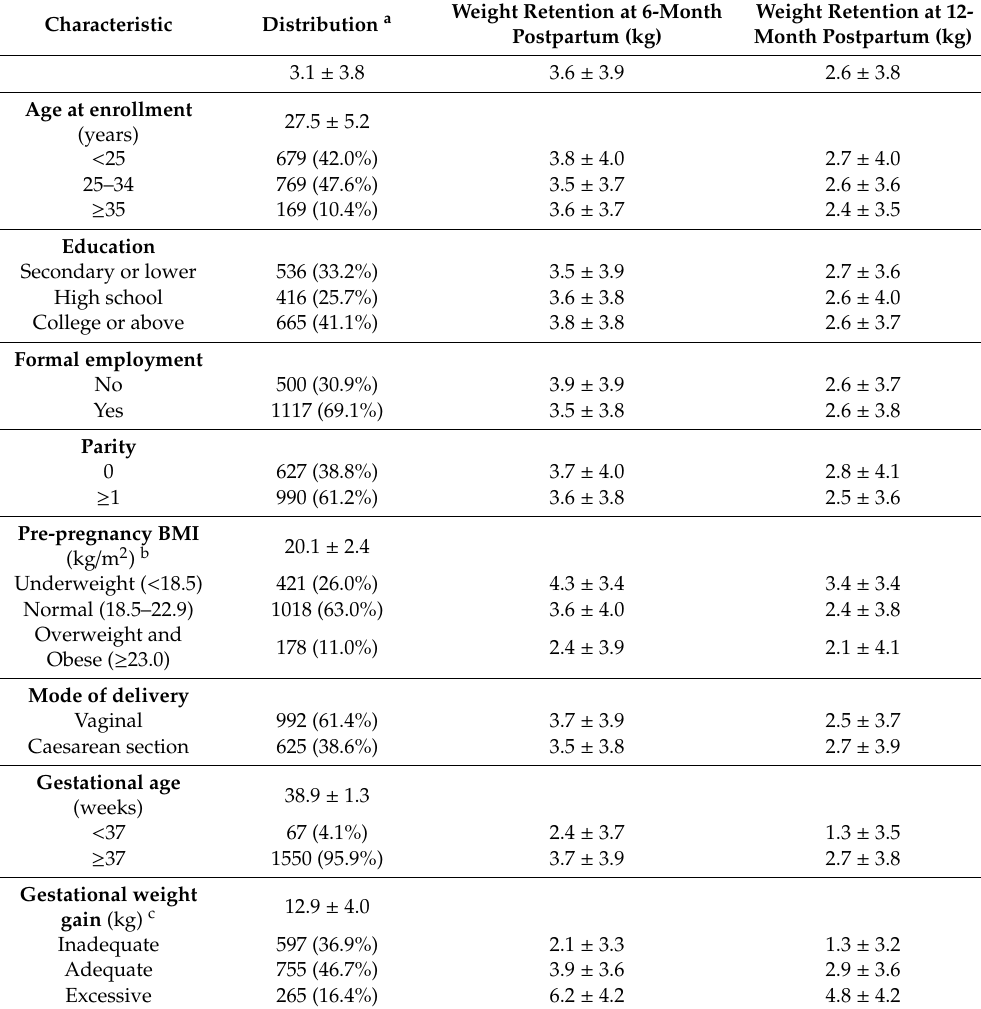
Table 1. Characteristics of the maternal cohort of the examined women ( n =